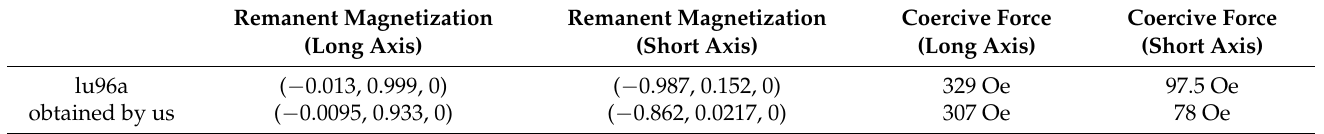
Table A1. Comparison of the obtained